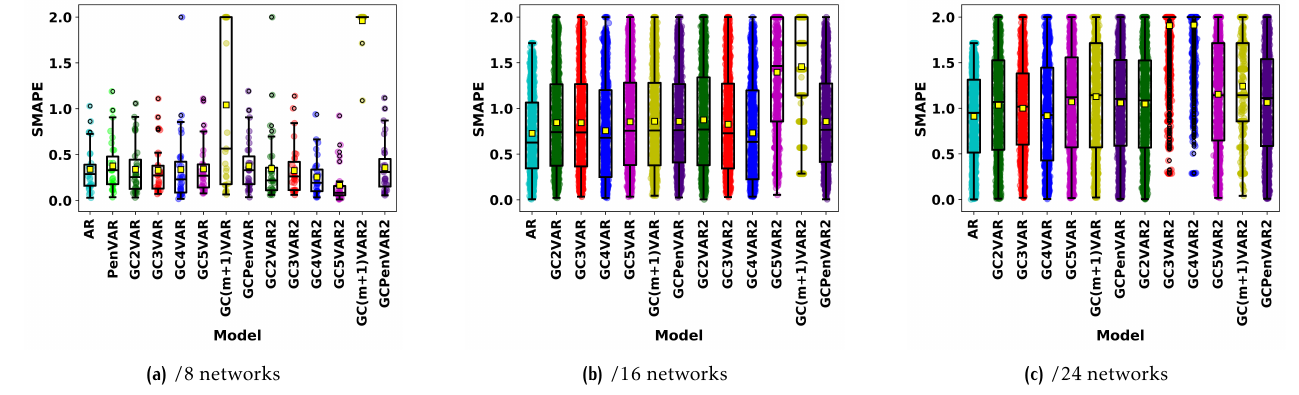
Figure 8. Box plots of the SMAPE values of different